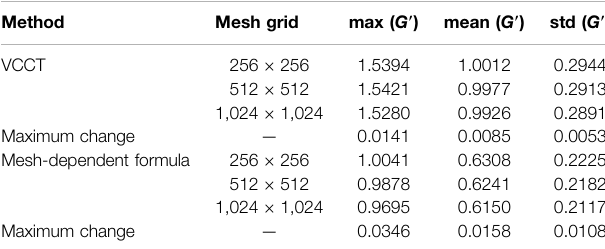
TABLE 2 | A summary of G ′ (cid:1) G ( θ ) / G analytic 2 of an internal penny-shaped crack determined by VCCT and mesh-dependent formula, i.e., Eq. 10 and Eq. 5 . max(),mean()andstd()arethefunctionsofevaluatingthemaximum,averageand standard deviationvalues of G ′ ( θ ∈ [0,360 ° )).Keyparametersarethesame asthat in the caption of Figure 4